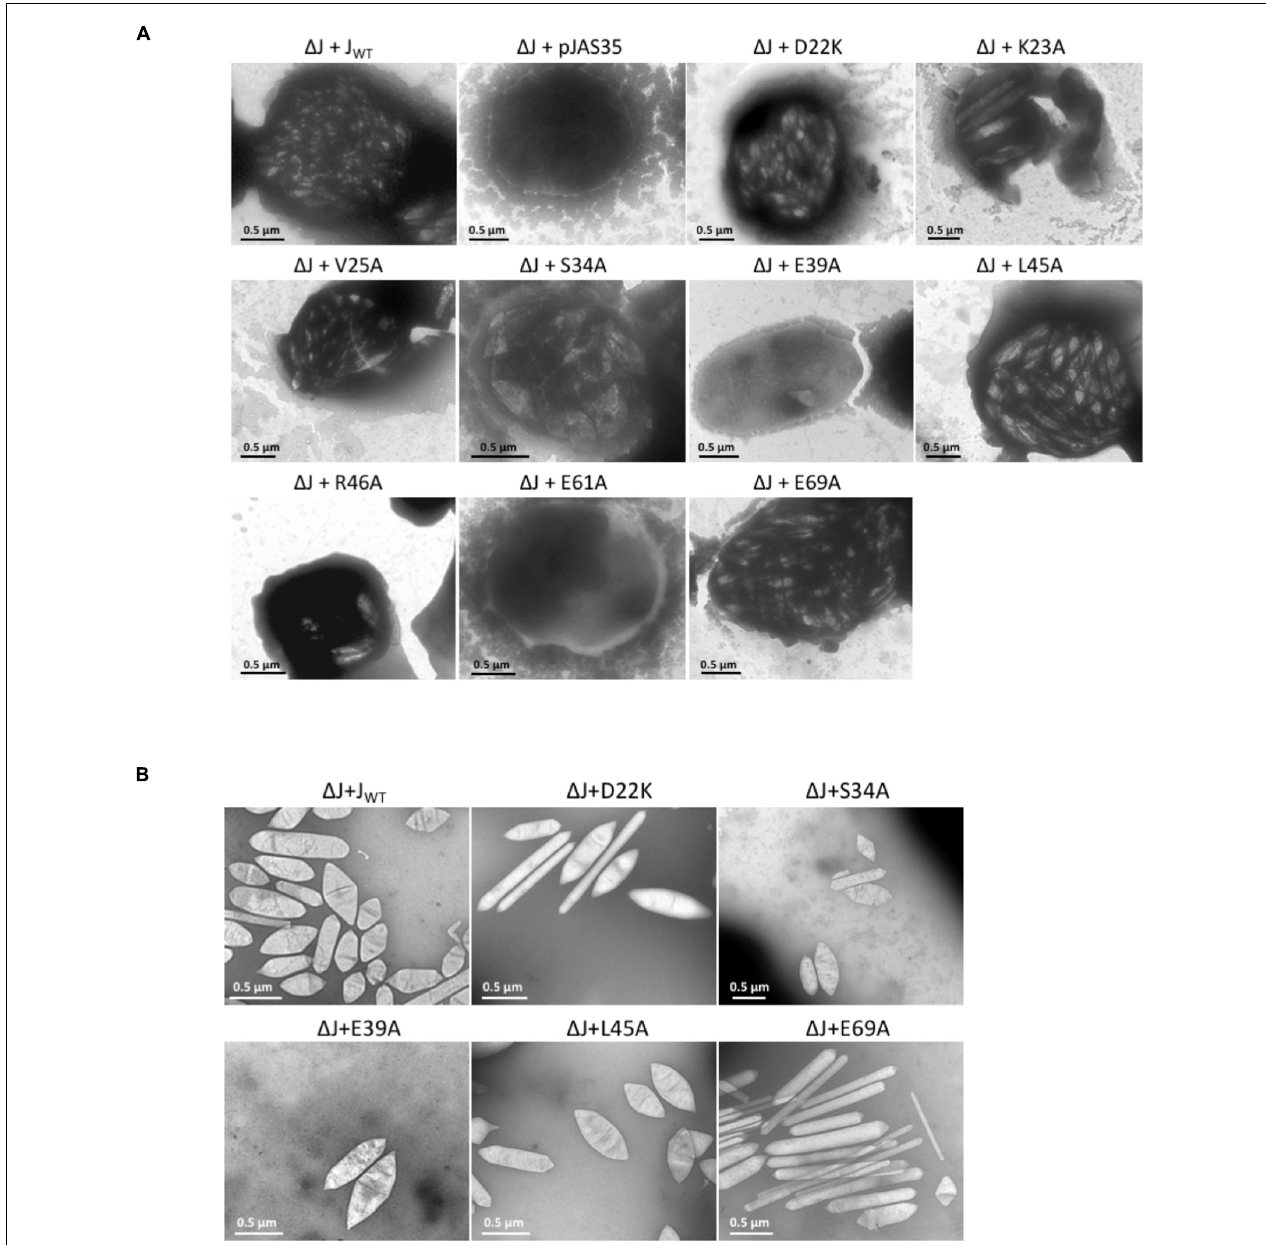
FIGURE 2 | Electron micrographs of Hfx. volcanii (cid:49) J + J wt or (cid:49) J + J mut transformants, and of isolated gas vesicles. The respective substitutions in GvpJ of the (cid:49) J + J mut transformants are indicated on top. (A) Representative cells of the different Vac + or Vac − transformants. Gas vesicles are seen as particles inside the cells. (B) Isolated gas vesicles of (cid:49) J + J wt and (cid:49) J + J mut